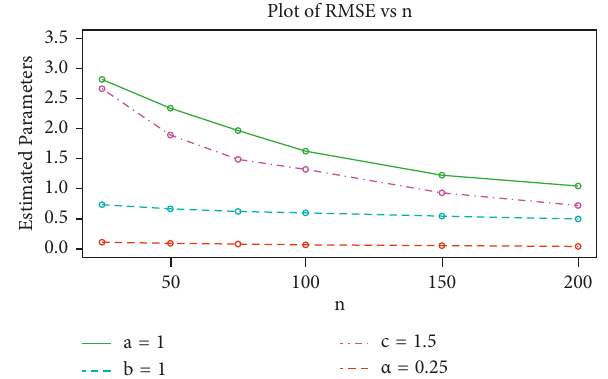
Figure 9: The plots of RMSEs for the ExEW parameters in set III.